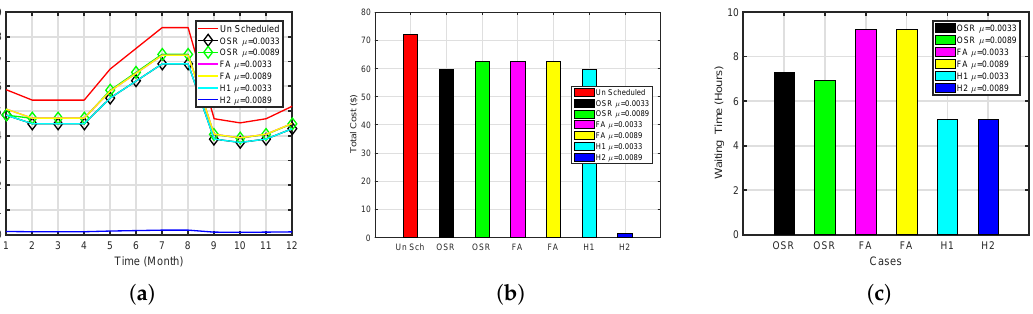
Figure 13. Cont . ( a ) Energy Consumption and Cost of Cloth Dryer, ( b ) Energy Consumption and Cost of Dish Washer, ( c ) Energy Consumption and Cost of Refrigerator.